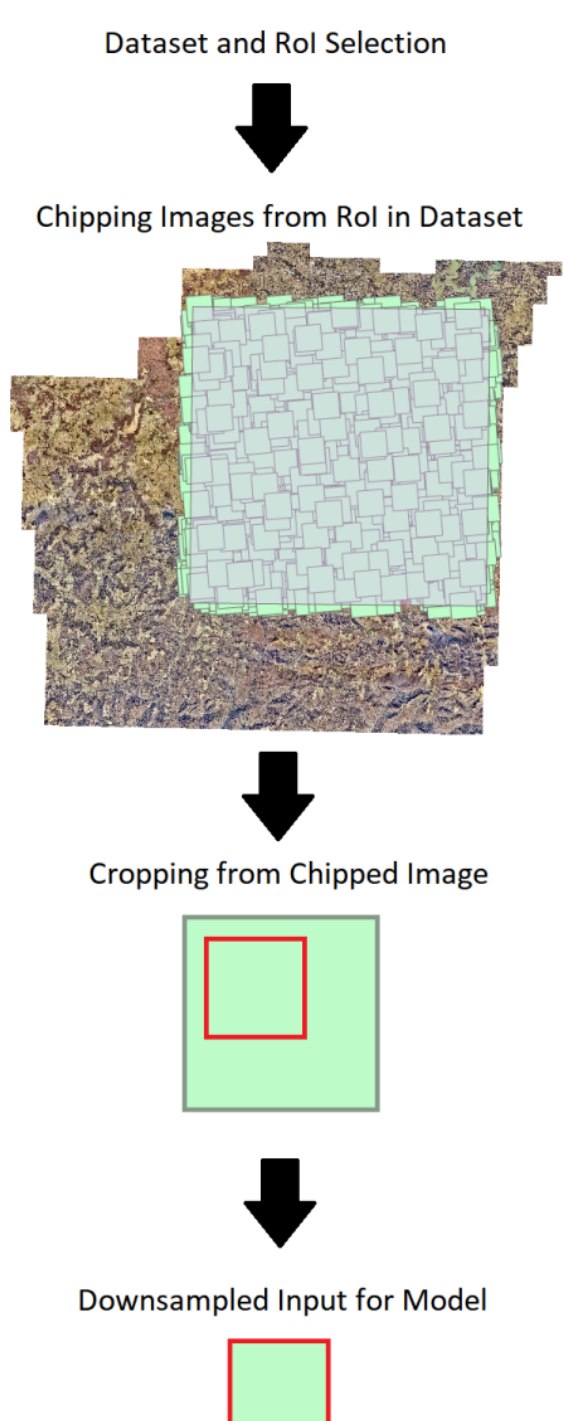
Figure 2. Figure demonstrating cropping setup. The transparent square over the county represents the ROI. The green squares are individual 3km x 3km image chips extracted from the base data set. 2000 random chips are taken from each data set to ensure overcoverage, with different random chips for each data set. The final step before use in network training is a random crop from each chip, shown in red. Downsampling occurs at both the chipping and cropping stages. Chipping is an offline step performed once. Cropping is an online step performed during every epoch with different random